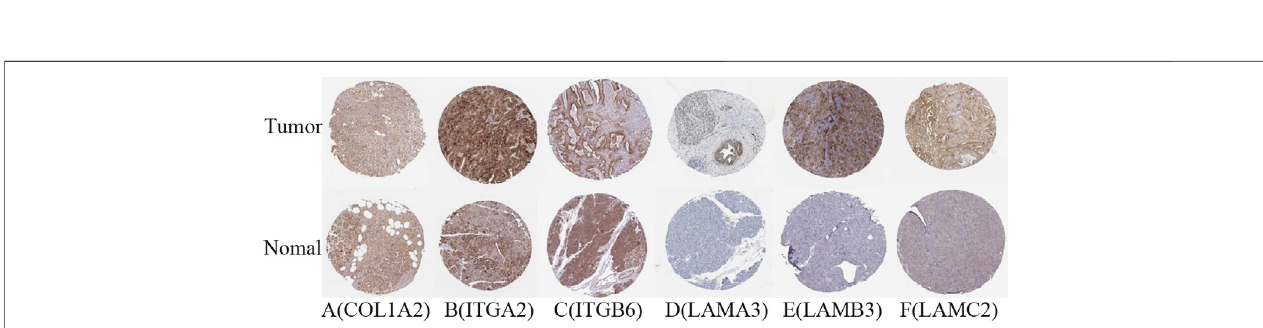
Frontiers in Genetics |